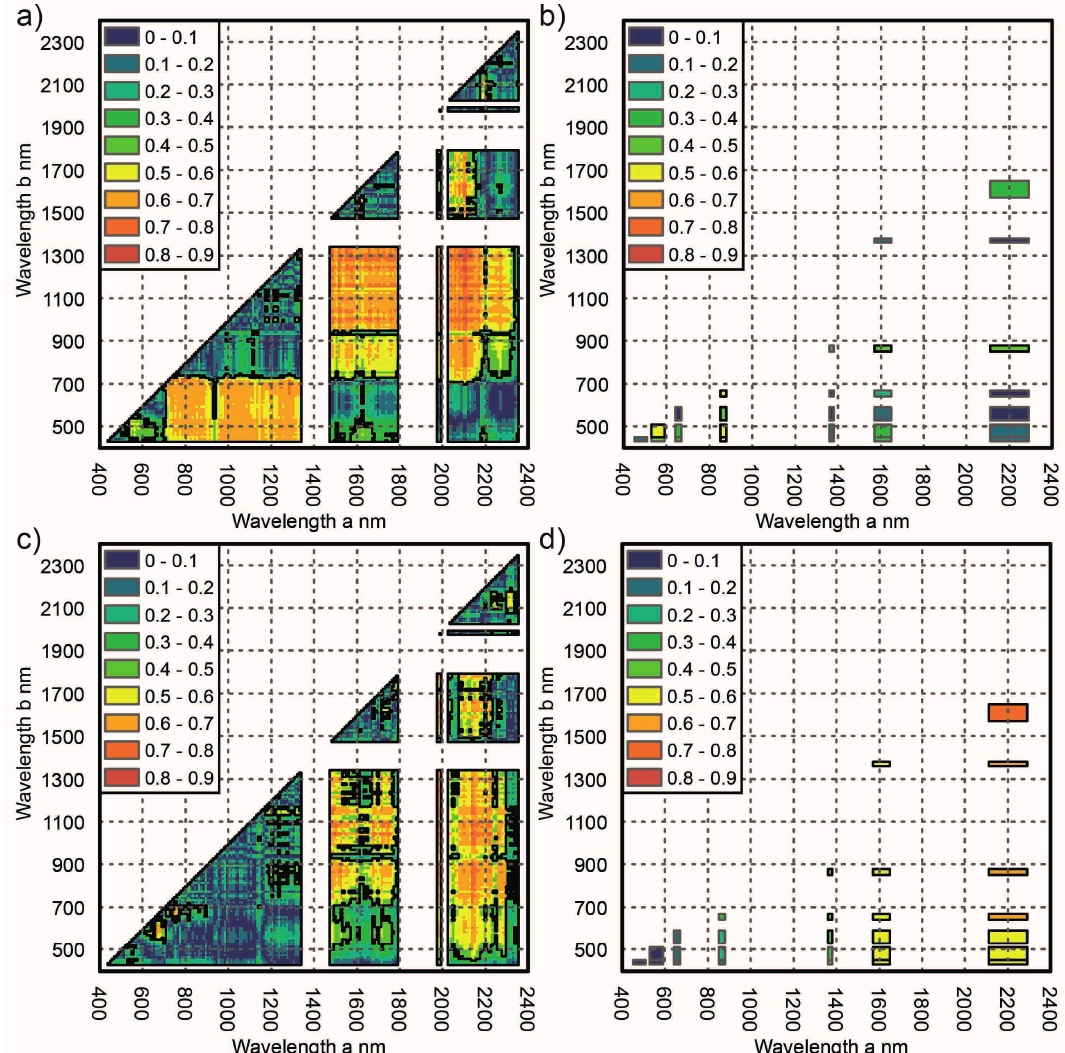
Figure 4. Absolute values of Pearson’s correlation coefficients R of biomass with indices from field sites of feature sets ( a ) H2012, ( b ) LS2013a, ( c ) H2013, and ( d ) LS2013b. Black lines mark significant values controlled at a FDR <